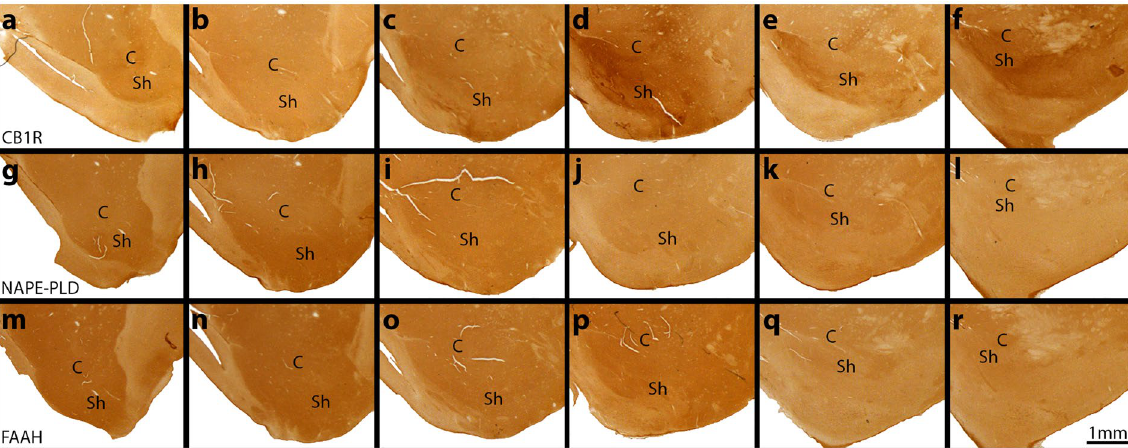
Figure 3. Spatial distribution of CB1R, NAPE-PLD, and FAAH throughout the rostrocaudal extent of the NAc. Coronal serial sections were taken adjacent to the CB stained slices in Fig. 2(a–f) Rostral sections show relatively homogenous staining of CB1R, but there is an increase of staining density in the medial portion of the shell beginning in mid-rostrocaudal sections ( c ). In ( d ) and further caudally, the CB1R expression is further increased in the medial shell. It is also noticeably augmented in the core and the ventral shell at these levels. ( g – l ) NAPE-PLD and ( m – r ) FAAH distributions remain relatively homogenous across the rostrocaudal extent. Scale bar = 1 mm. C = core; Sh =